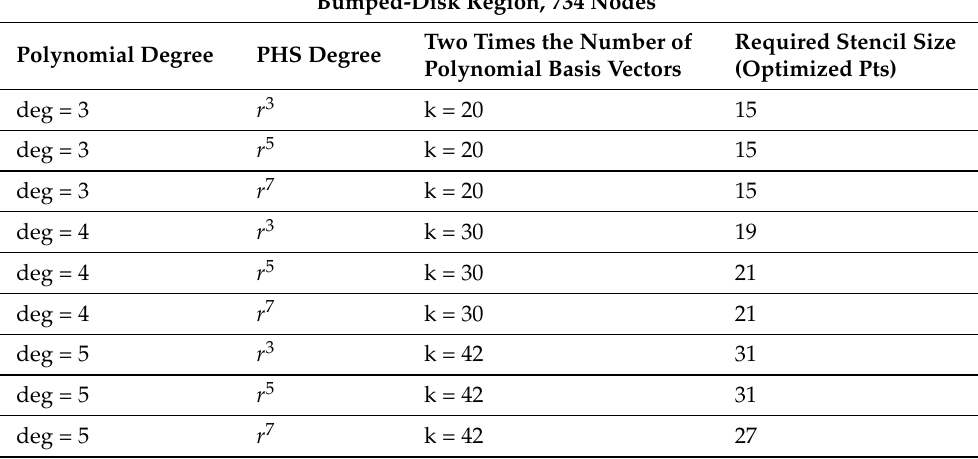
Table 2. Stencil size reduction for different selections of polynomial degree and PHS degree for the bumped-disk region.